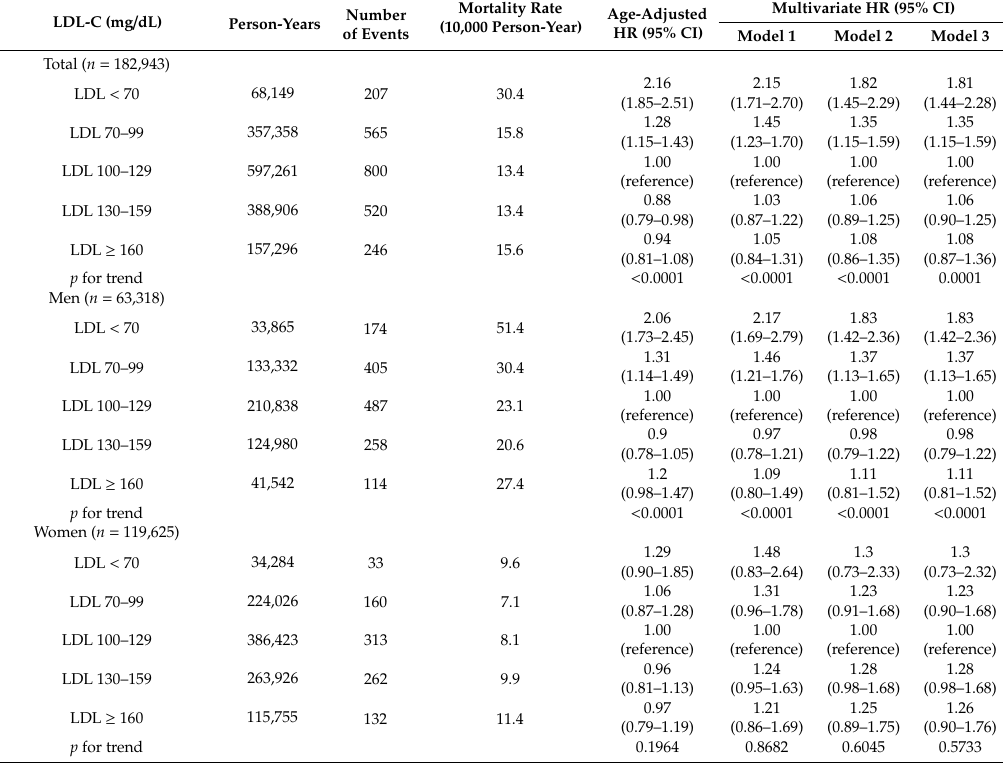
Table 5. Risk of all-cause mortality according to baseline LDL-C levels excluding subjects who died within 3 years of follow up in KoGES